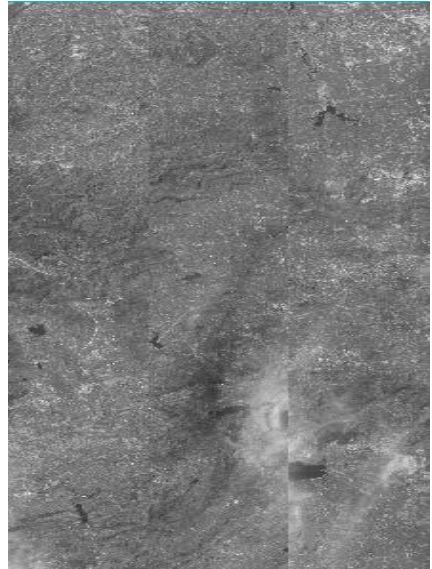
Figure 7. High Resolution (HR) image of ZY1-02C.